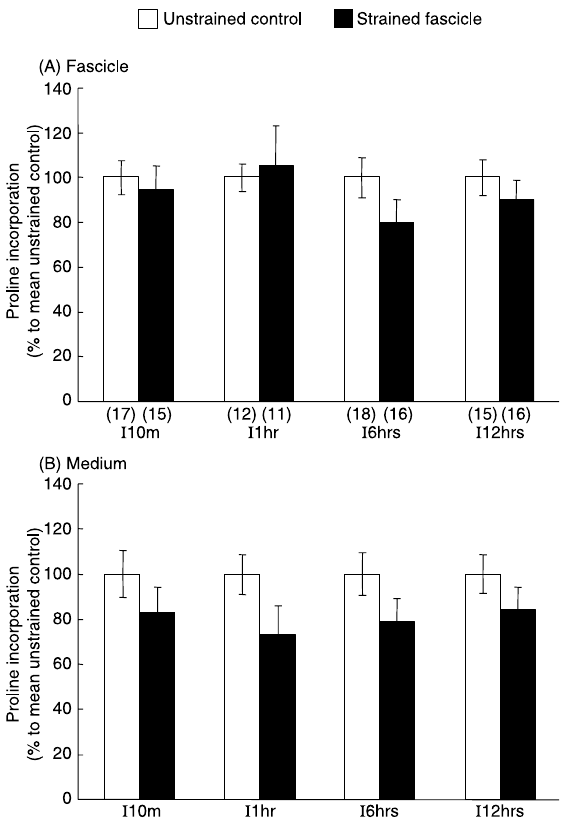
Fig. 3 The mean ± SE ratio of (a) the amount of [ 3 H]proline incorporation within the matrix of strained fascicles to that of unstrained control fascicles, and (b) release of incorporated [ 3 H]proline into medium. Values are expressed as the ratio to the mean of unstrained controls. White and shaded bars indicate values of unstrained controls and strained specimens, respectively. Numbers indicate the total number of samples. No significant di ff erences were